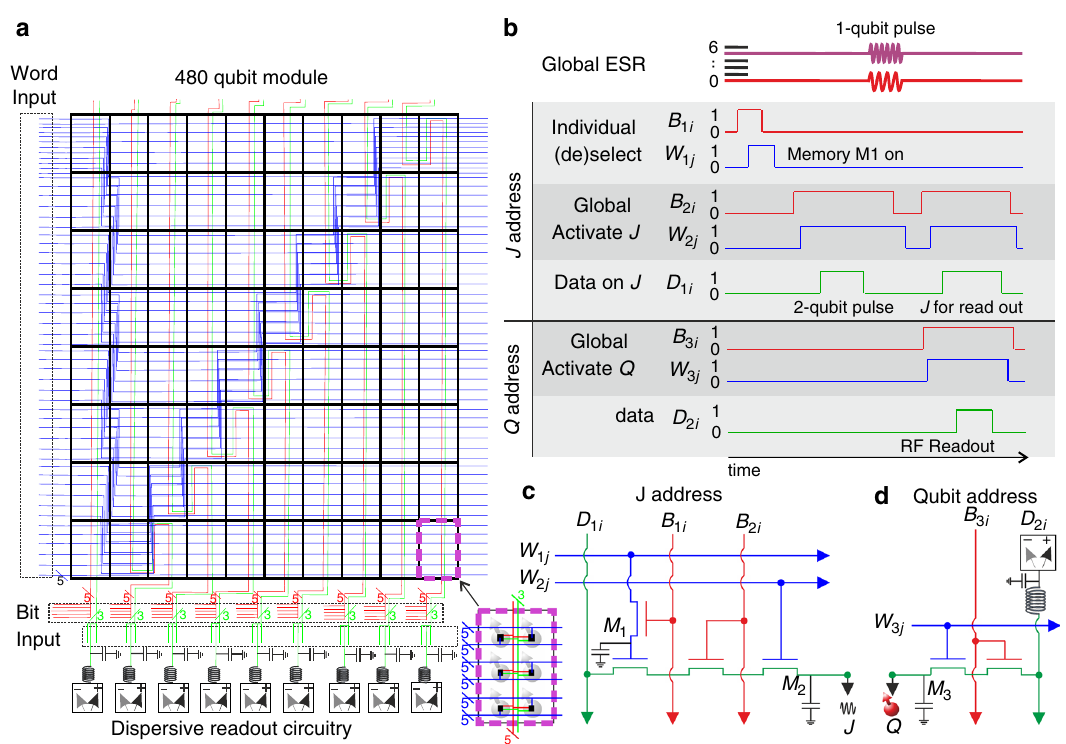
Fig. 3 Electrical circuit and qubit addressing scheme. a Electrical wiring of the 480 qubit module. The word lines ( W ), bit lines ( B ), and data lines ( D ) can be addressed to enable global control, to couple and readout row-by-row and to individually (de)select qubits. The W and B lines are grouped in fi ve and the D in three, such that a combination of these form the lines of the electrical circuit of a single extendable structure, consisting of a single qubit and two J gates. The zigzag structure in a is to accommodate for the different aspect ratios of qubit size, control size and in order to be consistent with surface code operation. The purple rectangle displays the region that is occupied by 6 qubits, corresponding to a surface code unit cell (see Fig. 4b). Note that the word lines are connected to the qubits in an alternating arrangement in order to make the circuit compatible with our spin qubit surface code scheme. b Typical operation protocol of the electrical circuit shown in c , d . Individual qubit selection is via lines W and B 1 that (de)charge fl oating electrodes ( M 1 in c ) and (dis)connect the data lines from the corresponding J -gates. Two-qubit operations are performed by activating the associated lines W 2 and B 2 and sending a pulse through data line D 1 . Global single-qubit operations can be applied by broadcasting an ESR pulse at the resonance frequencies of the corresponding subgroup of qubits at any time of the sequence. Readout is enabled via the lines W 2 , B 2 , W 2 , and B 3 . Then a pulse turns on the selected J gates, and RF readout is performed via the data line D 2 connected to the qubit. The electrical circuits in c , d show the corresponding structures to control the qubits and the exchange coupling between them. The fl oating memories M 1 and M 2 are to maintain the desired electric fi elds on the respective J and Q gates and may be periodically refreshed